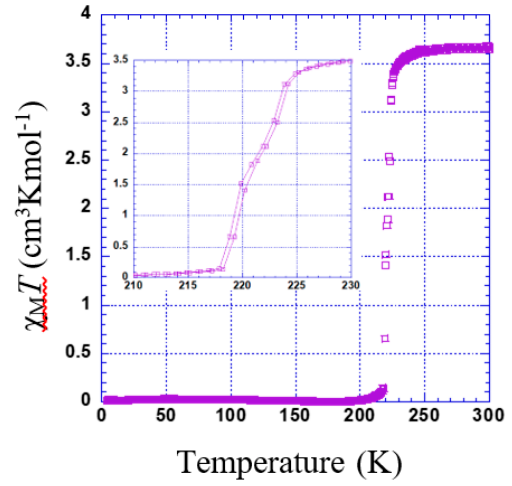
Figure 6. Thermal dependence of χ M T plot for 2 . Inset shows the range of 210 to 230 K.